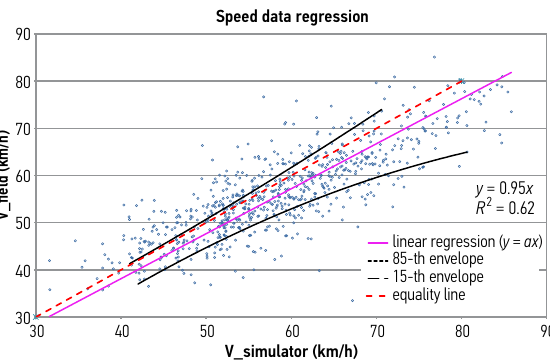
Fig. 10. Envelope of real speed dispersion data versus simulated speeds (15-th and 85-th percentile of